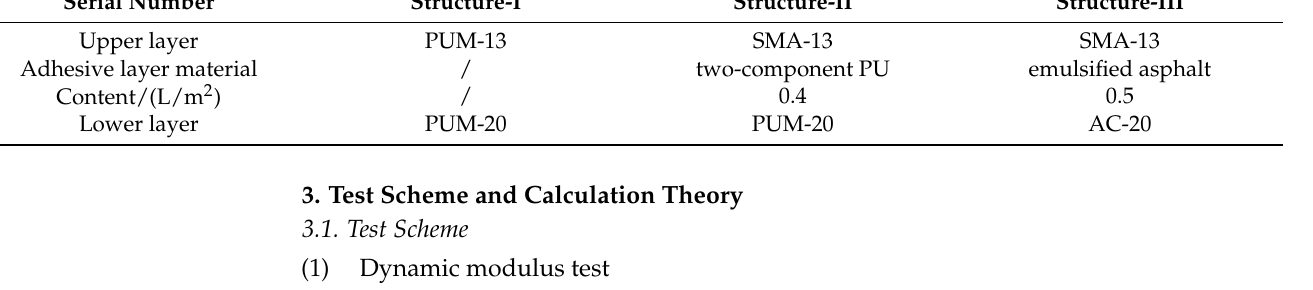
Table 3. Composite specimens of the three pavement structures.